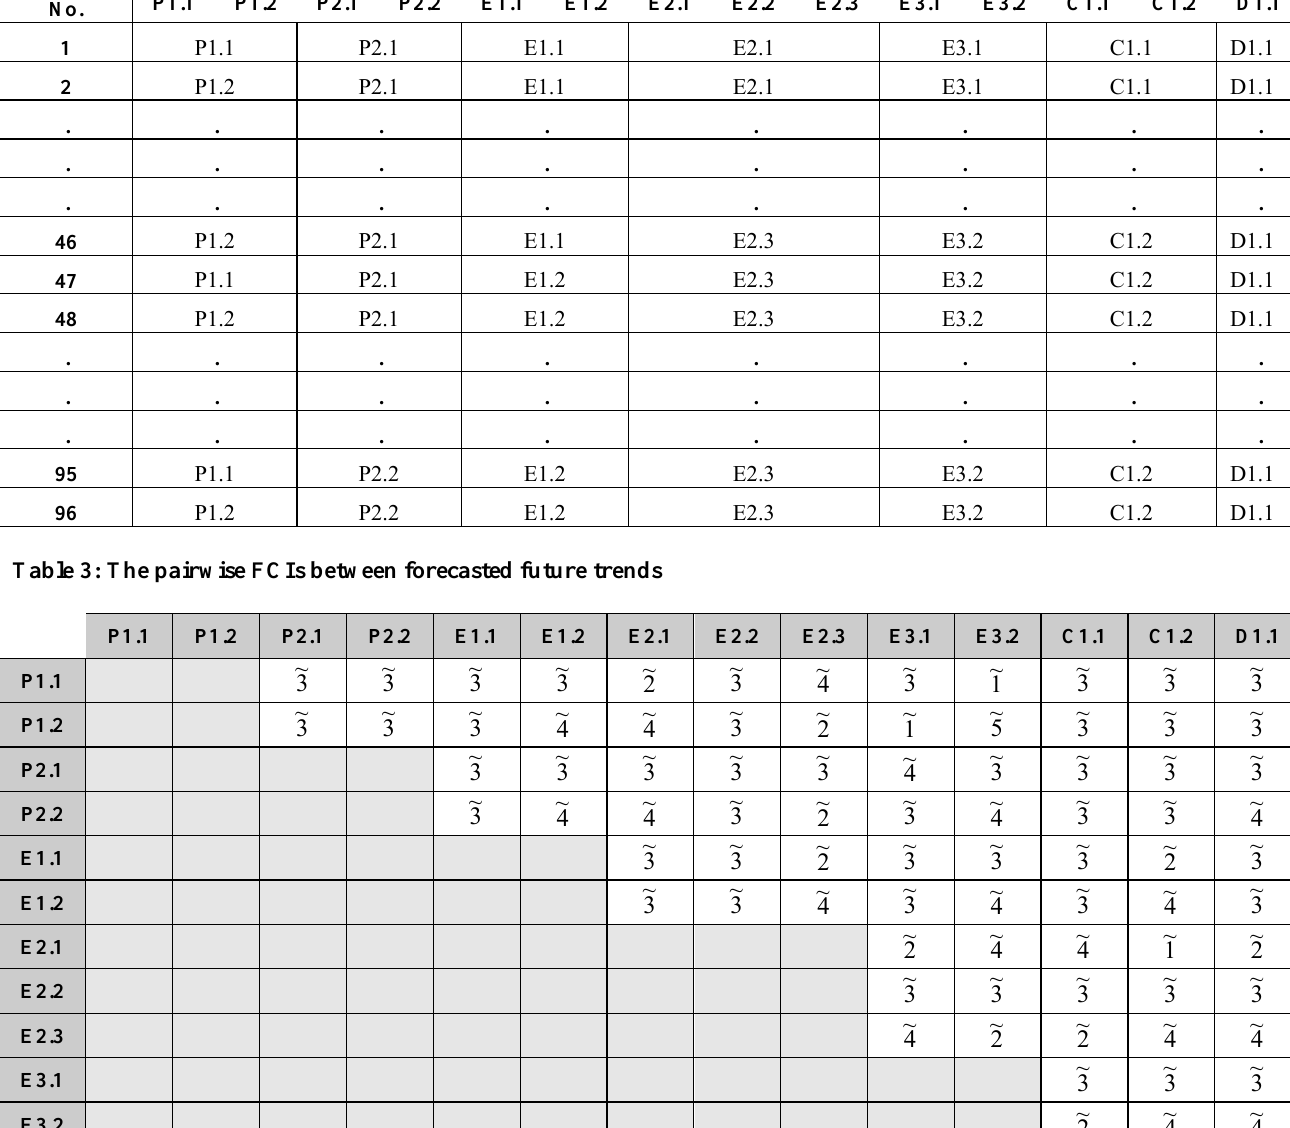
Table 2: All possible scenarios Scenario No.